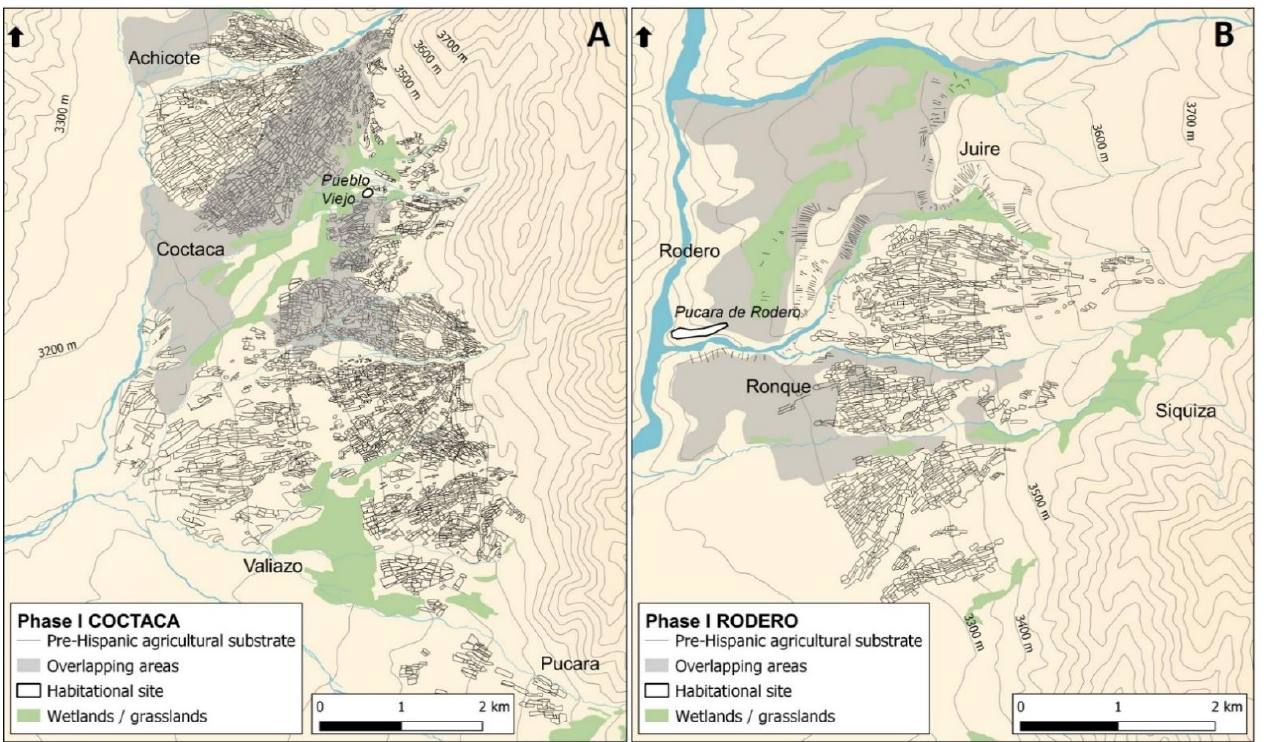
Land 2021 , 10 , x FOR PEER REVIEW Figure 3. Expansion of the pre-Hispanic agricultural substratum at ( A ) Coctaca and ( B ) Rodero.